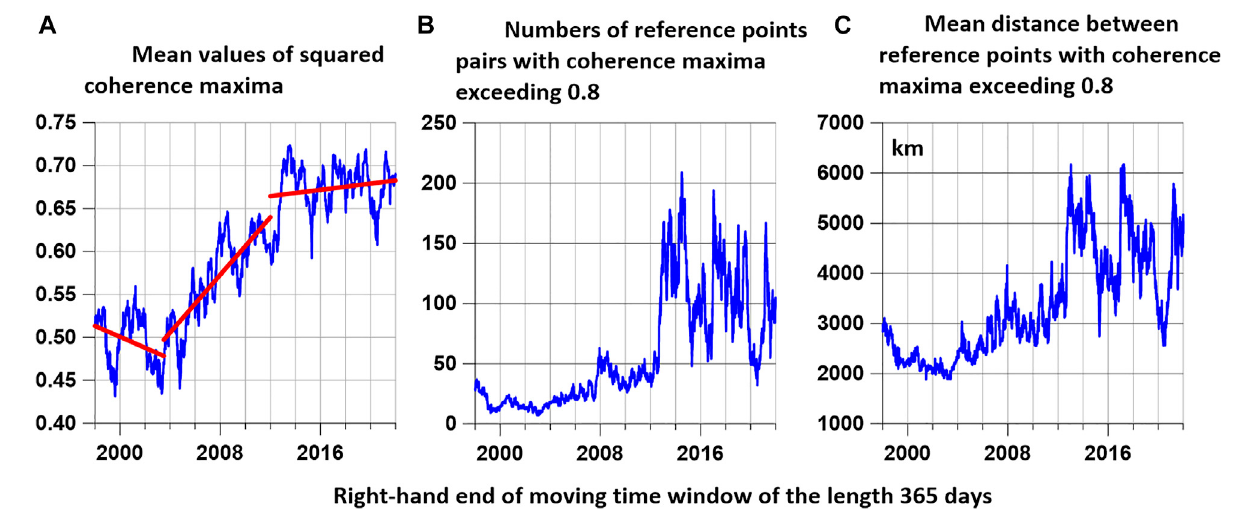
FIGURE5|(A) — plotofthemeanvaluesofthequadraticcoherencemaximabetweenthevaluesofthe fi rstprincipalcomponentofthe3seismicnoisepropertiesin all pairs of the network of 50 reference points on the Earth ’ s surface estimated in a sliding time window of 365 days with a shift of 3 days, the red lines represent linear trends on the time intervals of the right ends of the window 1998 – 2003.5, 2003.5 – 2012 and 2012 – 2022. (B) is a graph of the number of pairs of reference points for whichthemaximumcoherenceexceededthethresholdof0.8. (C) isthegraphofmeandistancebetweenreferencepointswithhighmaximumsquaredcoherence.